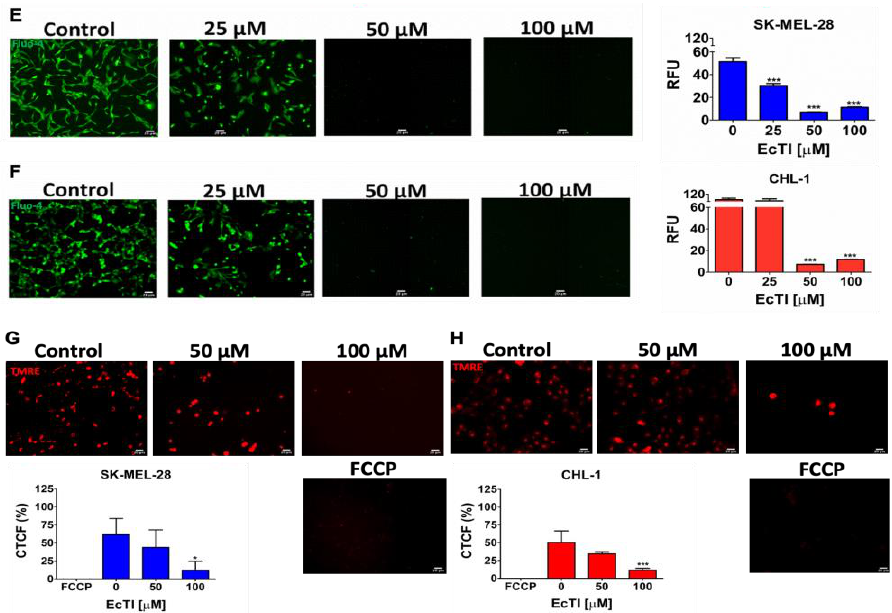
Figure 3. Nuclear morphology, PI uptake, calcium release, and mitochondrial membrane potential. Cell morphology to detect nuclear alteration in SK-MEL-28 cells ( A ) and CHL-1 ( B ) was determined using Hoechst staining after EcTI incubation for 24 h; pyknotic nuclei and nuclear shrinkage were observed after incubation with 100 µ M of EcTI. Loss of membrane integrity was calculated using PI fluorophore after incubation with 50 and 100 µ M of EcTI; extra fluorescence cells (particularly after incubation with 100 µ M of EcTI) were seen in SK-MEL-28 ( C ) and CHL-1 ( D ) (scale bar 20 µ m). Triton X-100 (0.01% v / v ) was used as a positive control of cell death. The effect of EcTI on calcium release was observed through fluorescence microscopy and using a microplate reader in the FLUO-4AM after incubation with 25, 50, and 100 µ M of EcTI (( E ) SK-MEL-28 and ( F ) CHL-1, scale bar 10